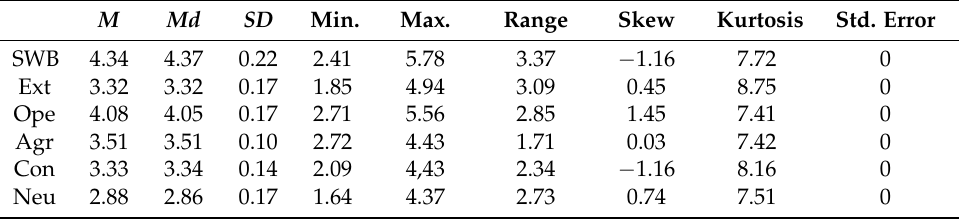
Table 2. Descriptive statistics for the predicted FFM traits and SWB score ( n = 21,122). M Md